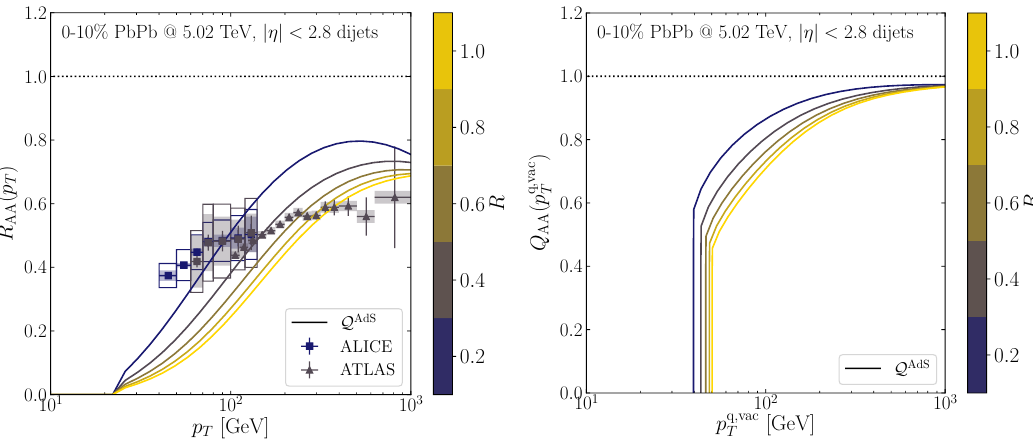
Figure 12 . The quenching and the quantile ratio in the strong coupling assumption with the proper quark and gluon mixture using eq. (D.7) and including the collimator to consider multi- parton effects from eq.